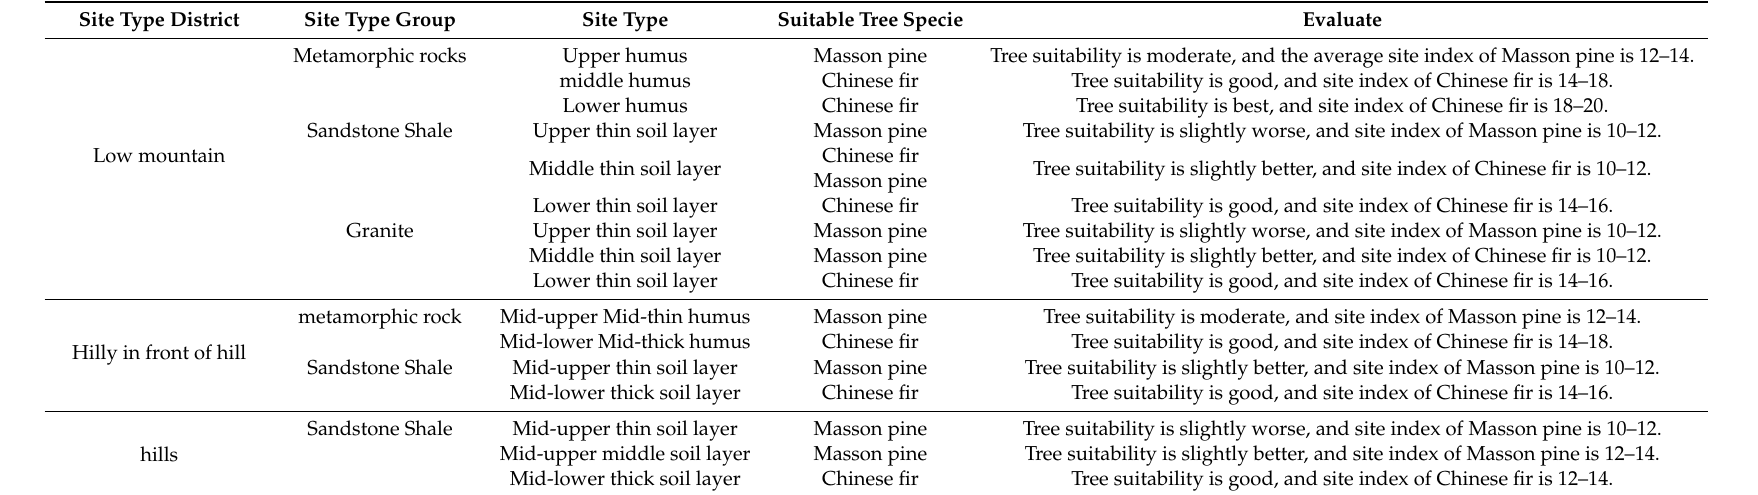
Table 4. Summary of empirical site rules from Guizhou Province Forest Management Information Collection in